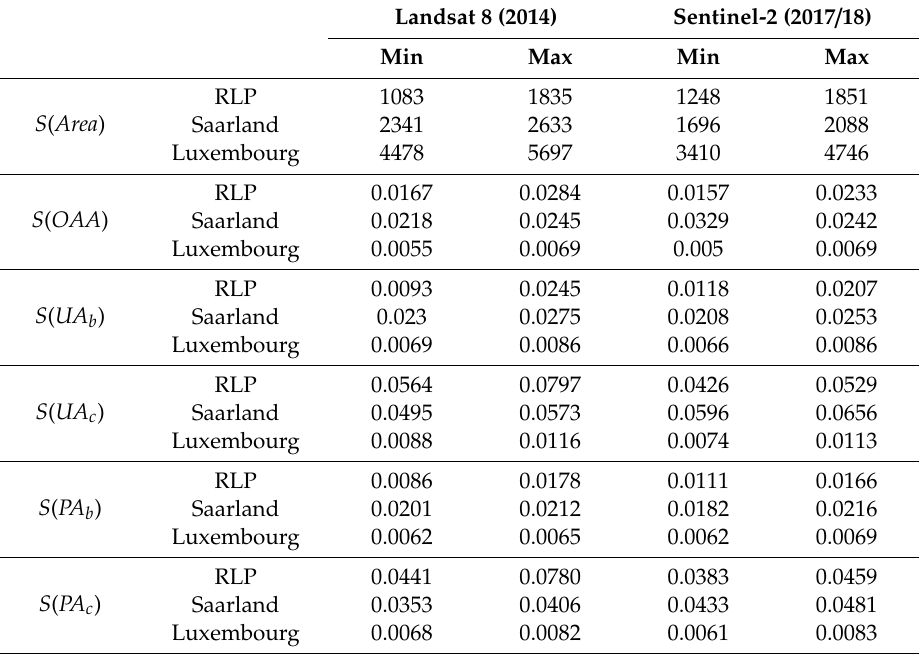
Table 6. Comparison of the mappings based on suitable Landsat 8 and Sentinel-2 VIs stratified by subregion. S ( Area ) reports the standard error for estimated area in hectares, S ( OAA ) for overall accuracy, S ( UA ) for the user’s and S ( PA ) for the producer’s accuracy; the subscript b stands for broadleaved and c for coniferous